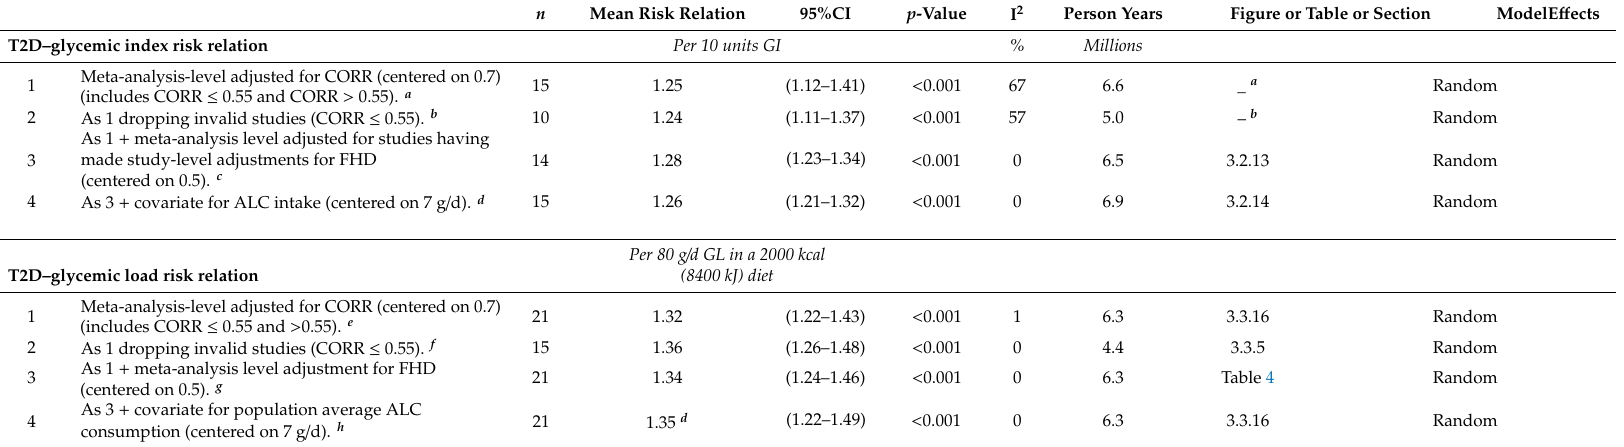
Table 8. Dose-response type 2 diabetes–glycemic index and –glycemic load risk relations with adjustments for covariates.